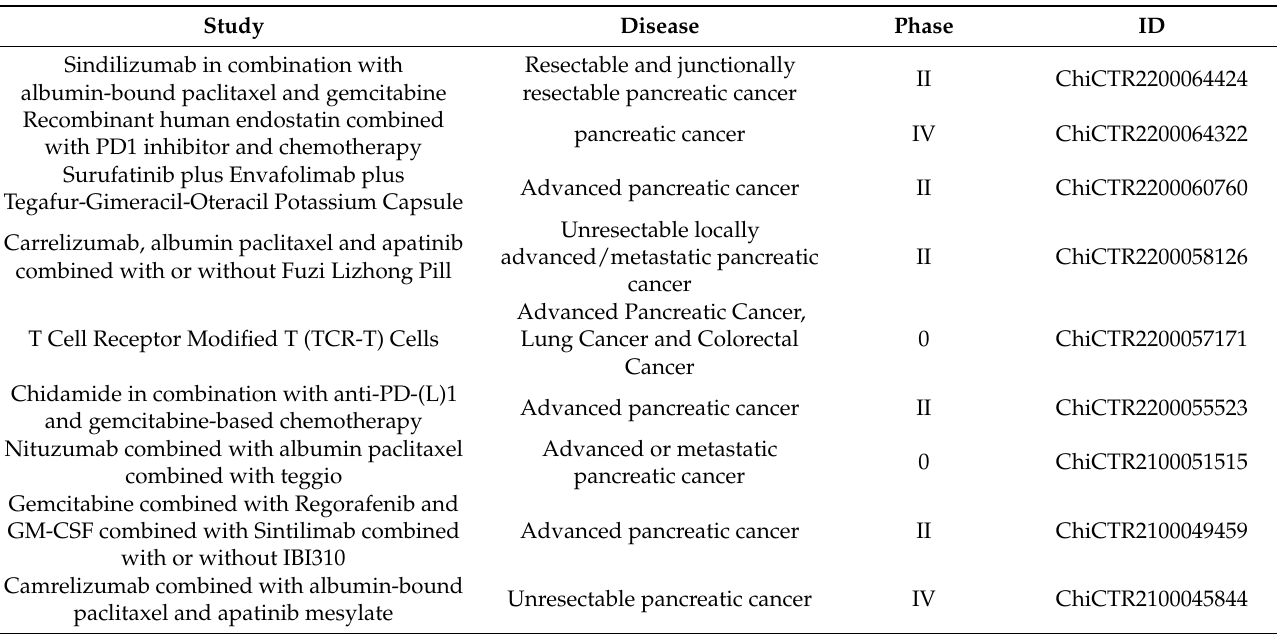
Table 6. Ongoing clinical trials investigating immunotherapy in pancreatic cancer.